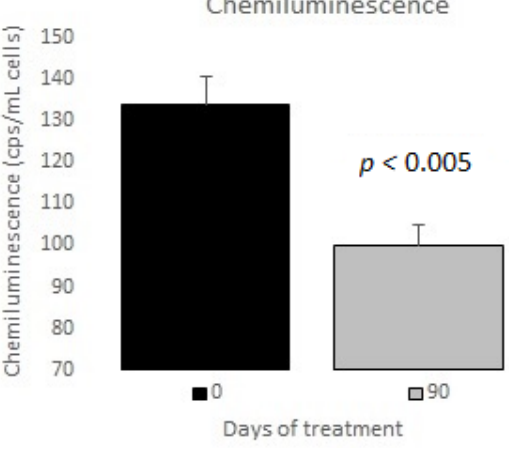
Figure 4. Chemiluminescence in neutrophils basal vs. 90 days of treatment with resveratrol, piperine and alpha-tocopherol in MetS patients.